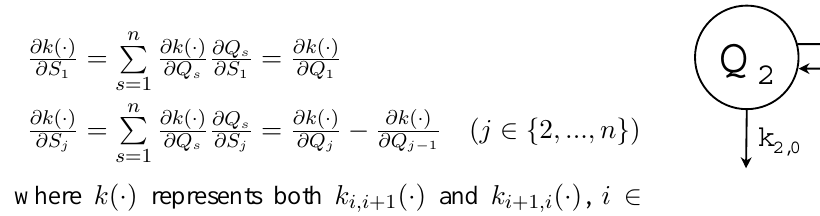
Fig. 2. Diagram of the linear glucose model developed by Cobelli et